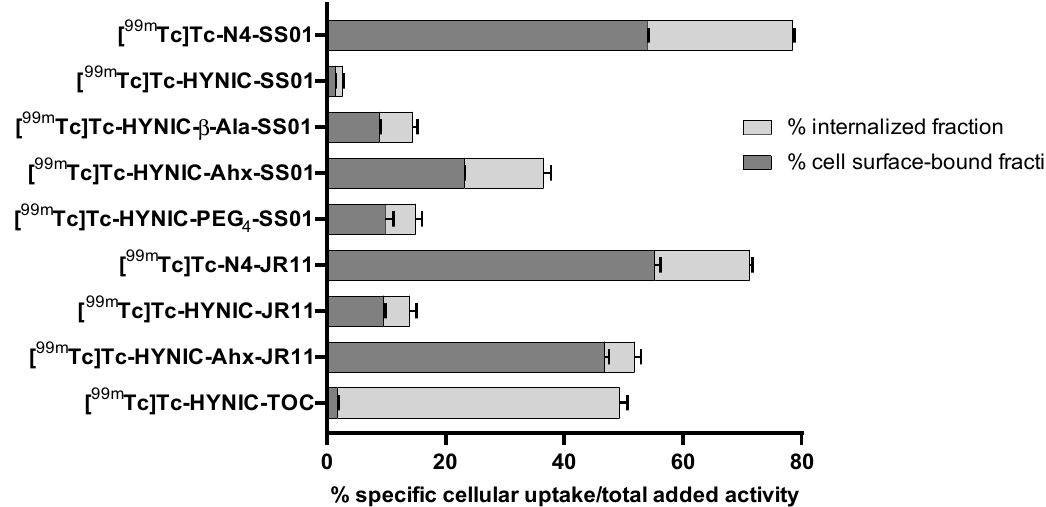
Figure 3. Cellular uptake (internalized fraction in light grey and cell surface-bound fraction in dark grey) of all the radiotracers in HEK-SST2 at 4 h/37 °C. The results are expressed as % (mean ± SD) of applied activity in the cells and normalized per million cells. All values refer to specific internalization and bound after subtracting the non-specific (measured in the presence of 1000-fold excess of blocking agent) from the total internalized and bound fractions.